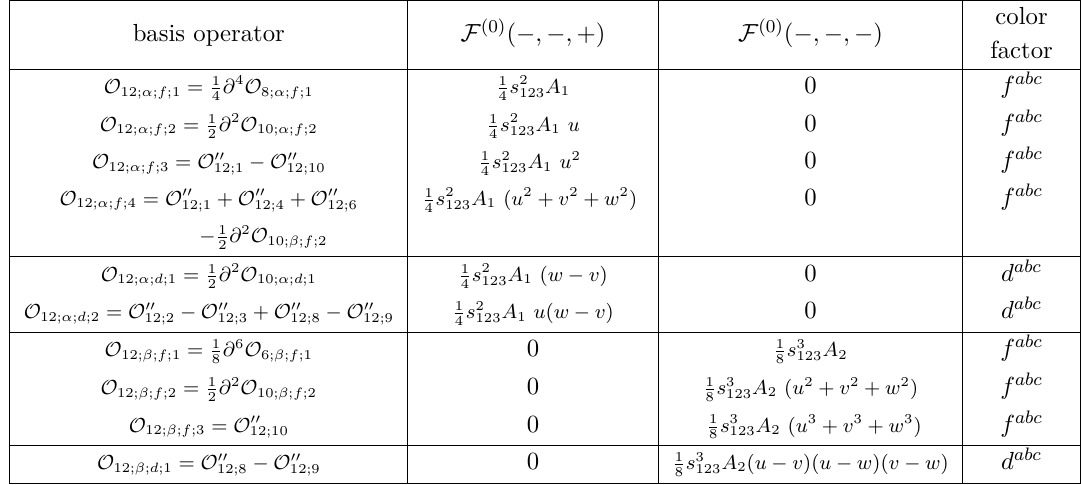
Table 14 . Final basis operators at dimension